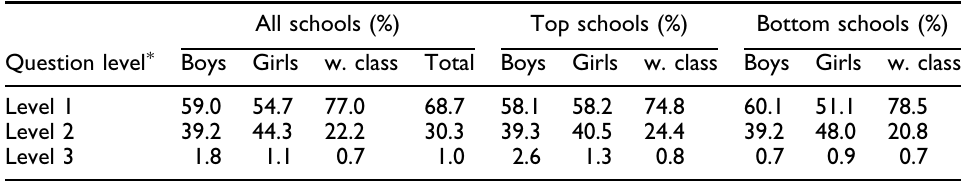
Table 4. Level of difficulty of question asked by the teacher and gender of respondent. All schools (%) Top schools (%) Bottom schools